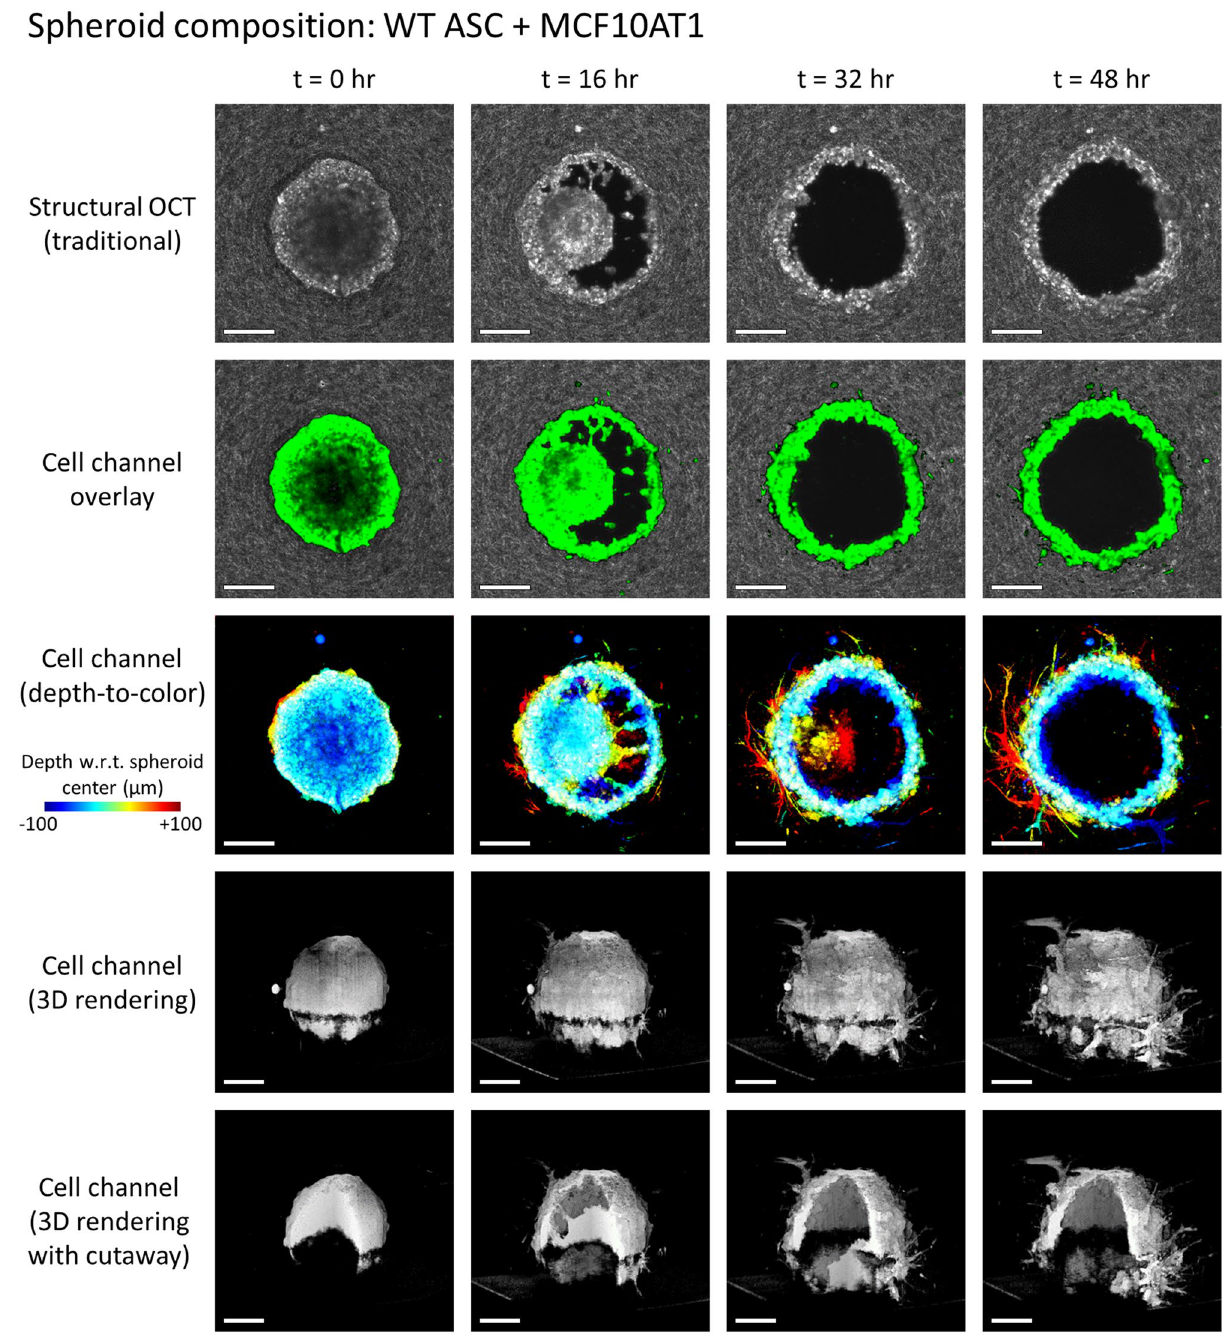
Figure 2. Invasion of a WT ASC + MCF10AT1 co-culture spheroid into the surrounding collagen substrate, revealed via label-free OCM imaging and temporal speckle contrast. Traditional OCM imaging (top row) records scattering signals of cells and collagen alike. Temporal speckle contrast enables segmentation of volumetric data into synthetic ‘cell’ and ‘collagen’ channels (rows 2–5). Scale bars = 200 µm. See text for details. Time-lapse animation is available in Supplementary Video